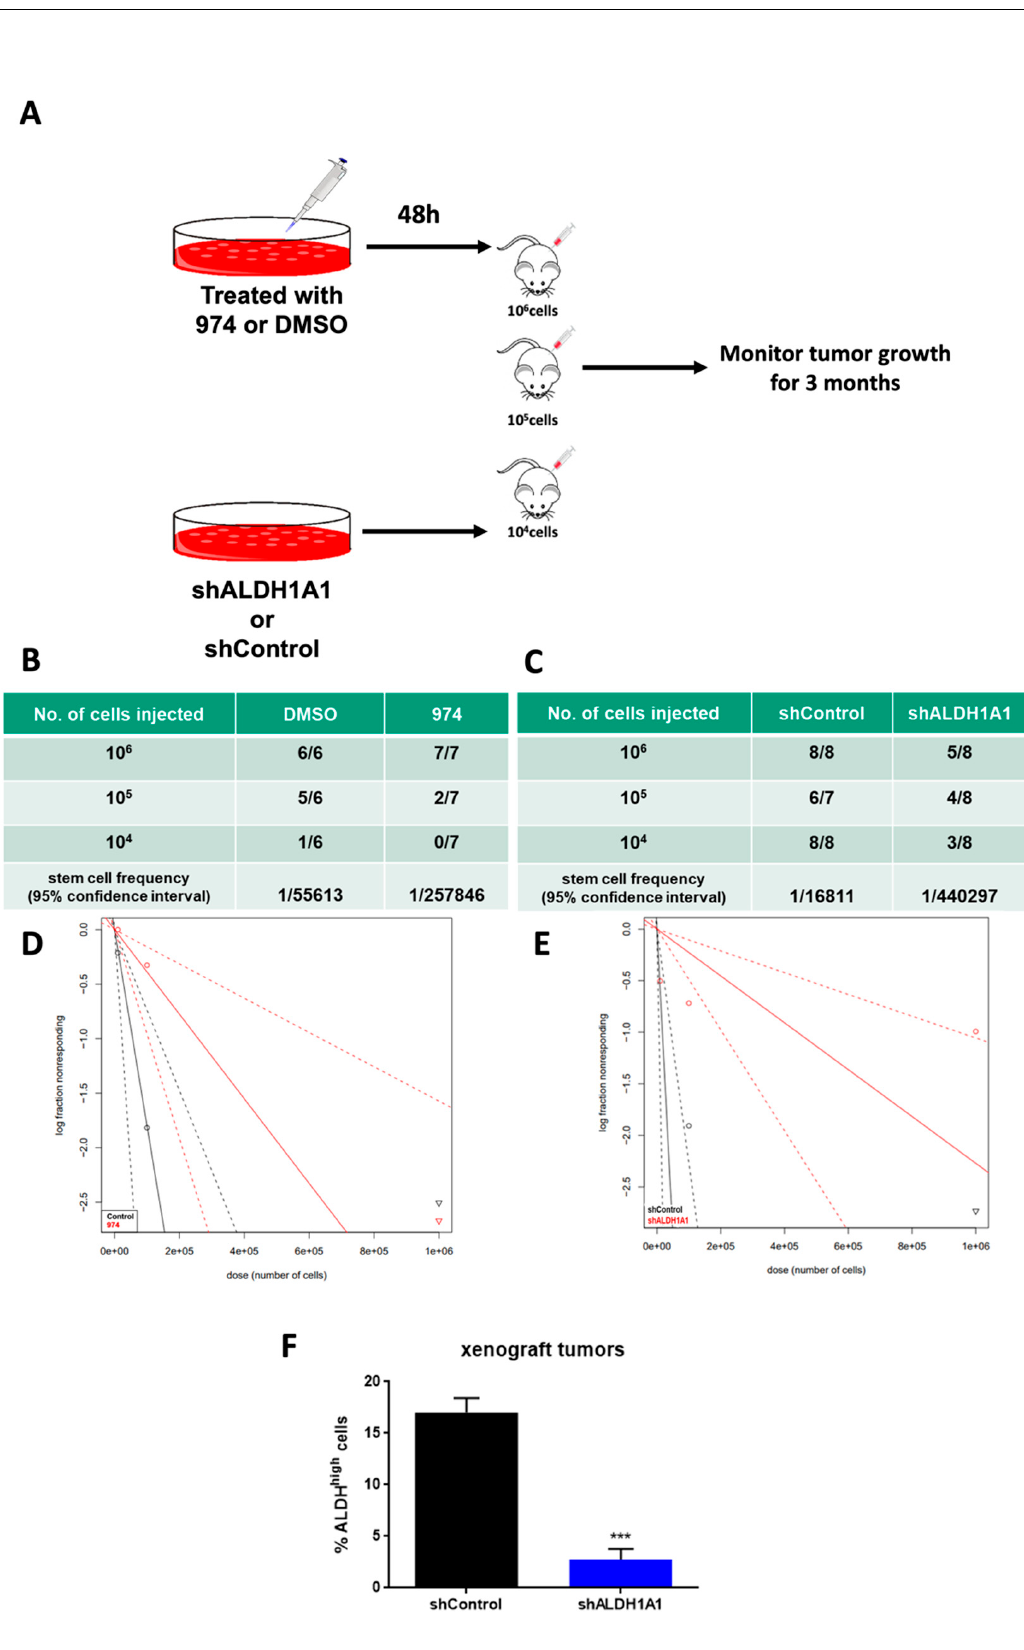
Figure 3. ALDH1A1 inhibition suppresses ovarian cancer stemness in vivo. ( A ) Schematic representing study design. Injections of 10 6 , 10 5 , or 10 4 OVCAR3 cells treated with compound 974 (5 µM for 48 h), DMSO OR shALDH1A1, or shControl cells were given to NSG mice subcutaneously, and tumor formation was monitored. The numbers of mice with tumors over the total numbers of mice in the group and the CSC frequency were calculated by ELDA software (https://bio- for shControl or shALDH1A1. The log-fraction plot of limiting dilution analysis for stem cell fre- quency generated by extreme limiting dilution analysis in ( D ) compound 974 treatment vs DMSO